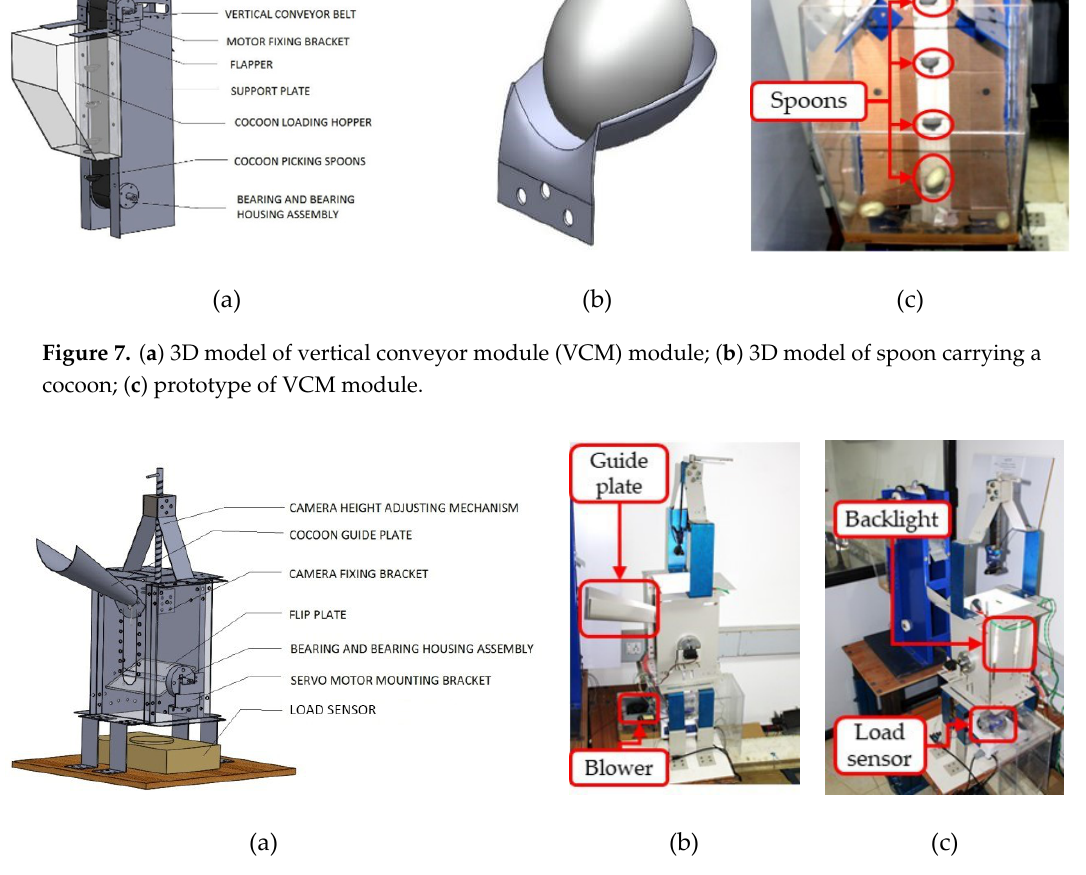
Figure 8. ( a ) 3D model of FEM; ( b ) and ( c ) prototype of FEM shown in two different angles.